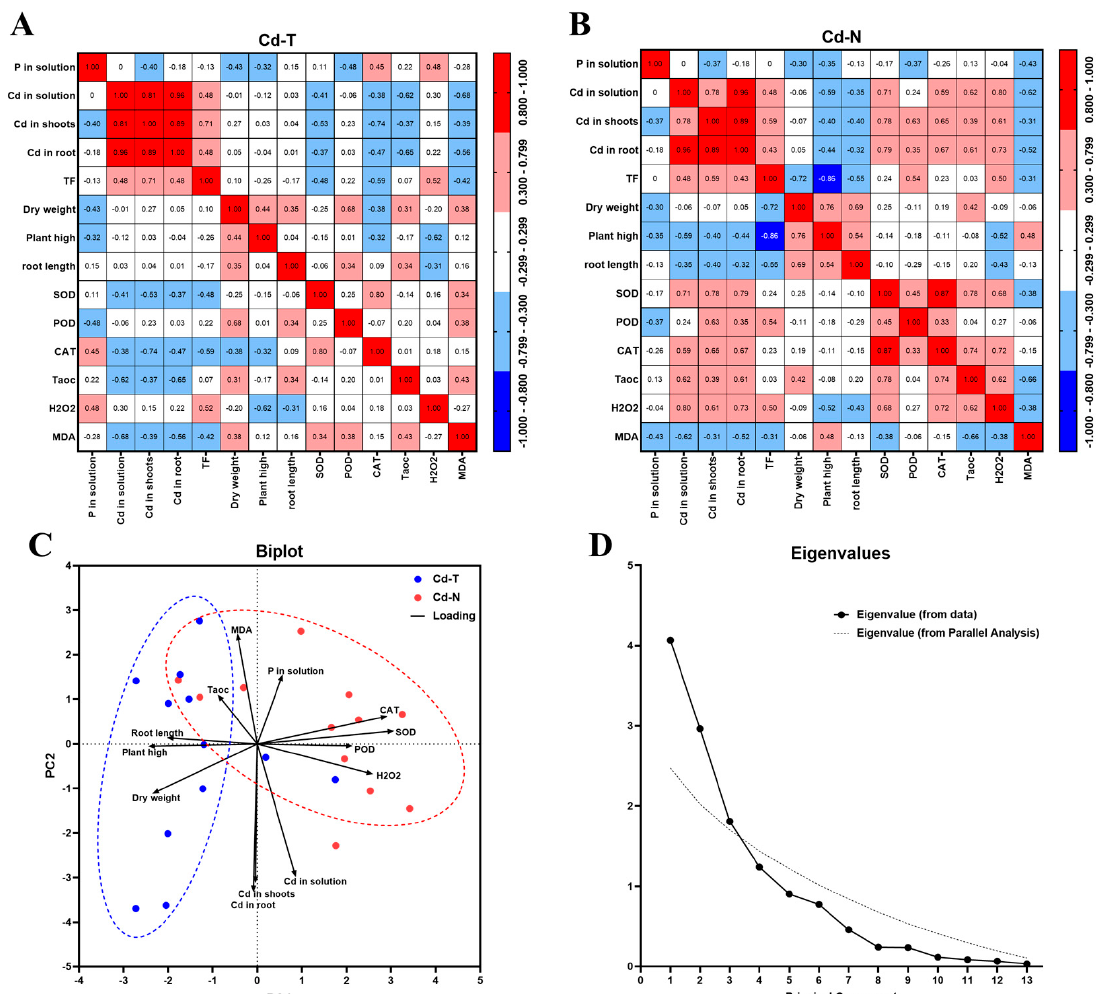
Figure 2. Correlation analysis and principal component analysis between Cd-T and Cd-N indicators. ( A ) Correlation analysis of Cd-T; ( B ) Correlation analysis of Cd-N; ( C ) Biplot figure of principal component analysis; ( D ) Eigenvalues.